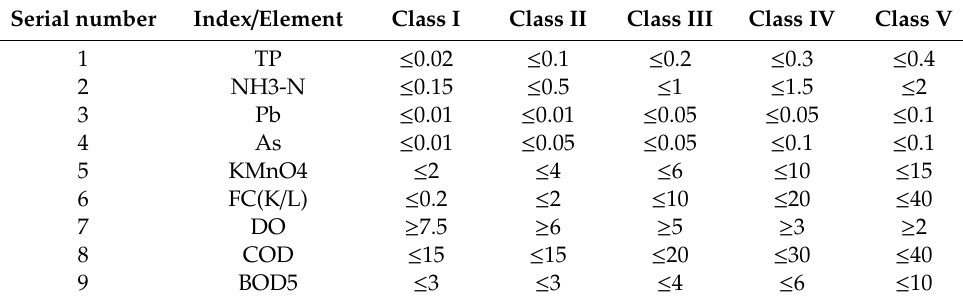
Table 3. Surface water quality